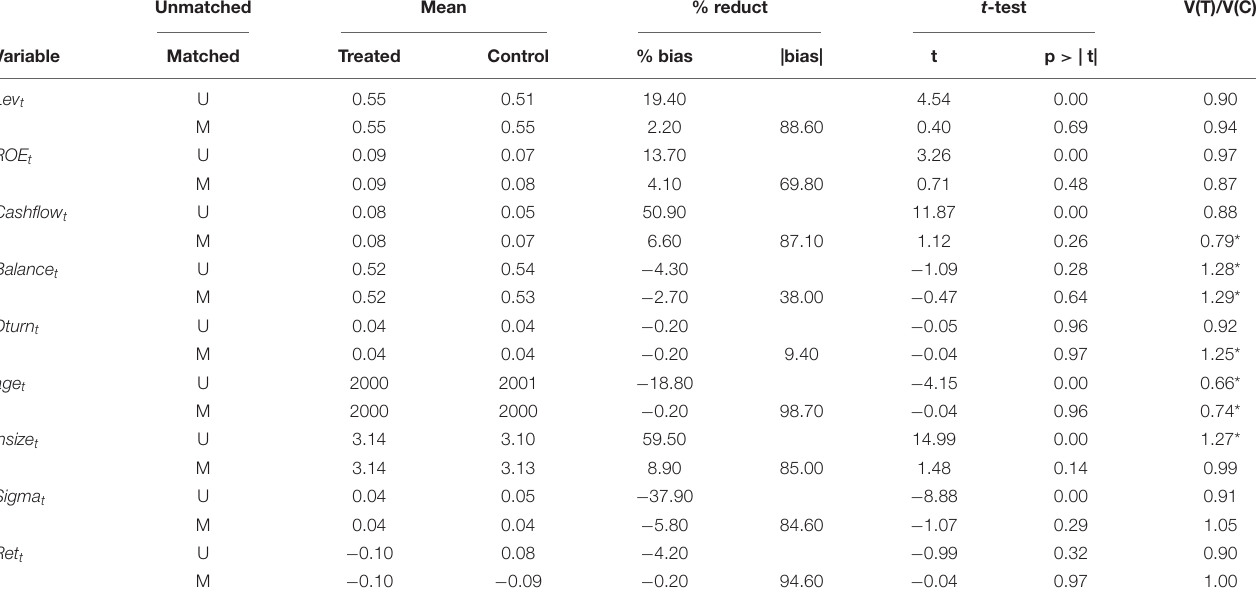
TABLE 4 | Matching